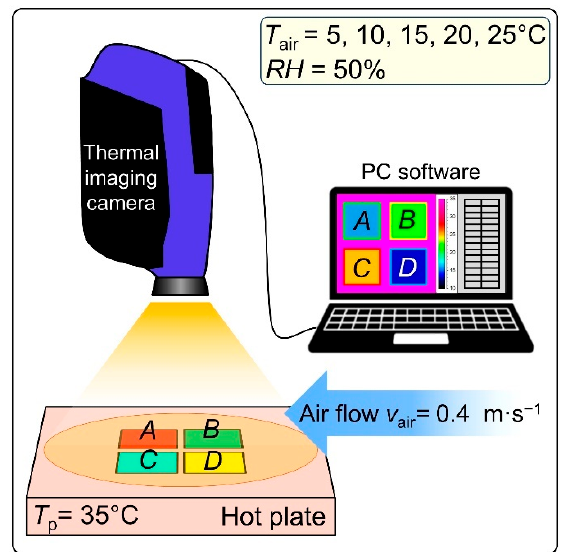
Figure 4. Scheme and initial conditions of thermal imaging.